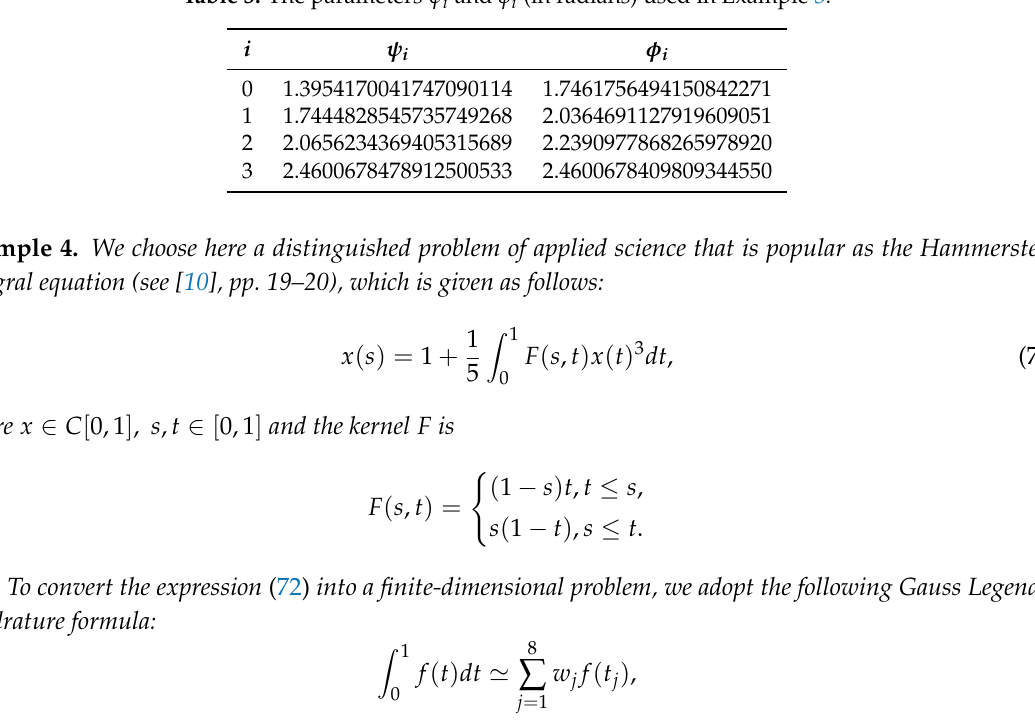
Table 3. The parameters ψ i and φ i (in radians) used in Example